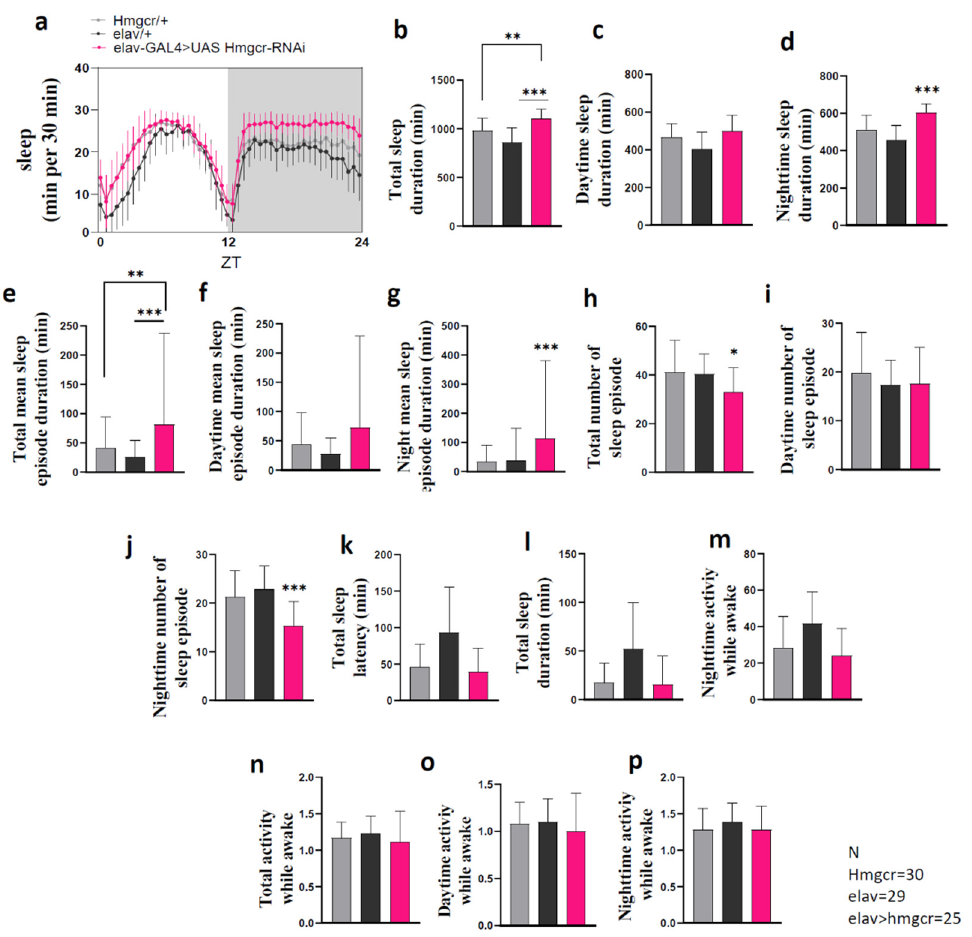
Figure 2. Hmgcr pan-neuronal knockdown in females increases sleep at night. ( a ) Wild-type flies male and females; male flies have a more robust siesta than females. ( b – p ) Sleep at night, sleep episode duration, max sleep episode duration, and a number of sleep-episode frequency at night between controls ( elav-GAL4 \ + and UAS-HMGCR RNAi \ +) and the experimental group ( elav-GAL4 > UAS HMGCR RNAi) have significant differences. Graphs with errors bars indicate ± S.D. n = 32 for each group. To detect the significant difference between groups a Shapiro–Wilk test was performed to determine normality, then a One-way ANOVA and Bonferroni post hoc test was performed. * p < 0.01, ** p < 0.001, *** p < 0.0001.